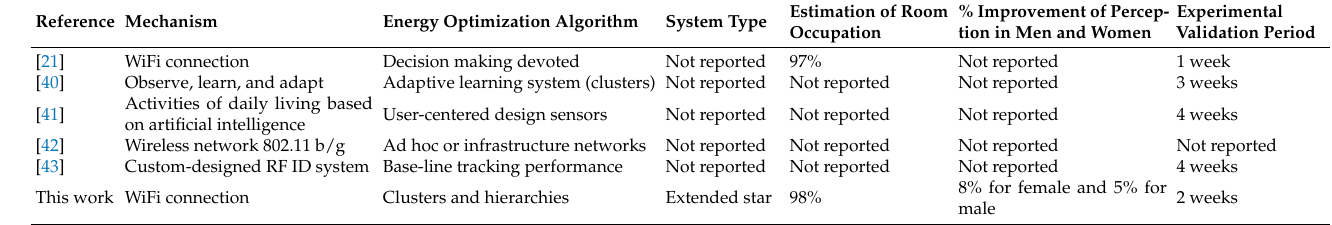
Table 5. Comparison of parameters and mechanisms in sensor networks for monitoring older adults at